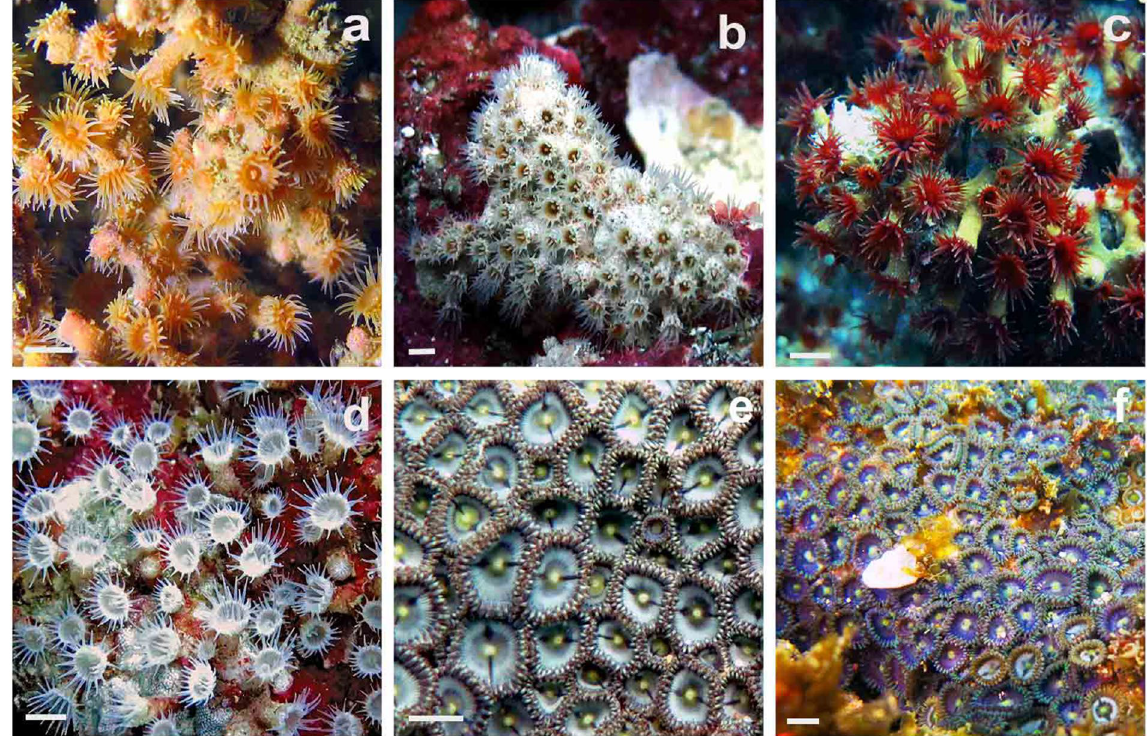
Figure 1. In situ images of the six zoantharians species discussed. ( a ) Parazoanthus darwini (Z1); ( b ) Antipathozoanthus hickmani (Z2); ( c ) Terrazoanthus patagonichus (Z3); ( d ) Terrazoanthus sp. (Z4); ( e ) Zoanthus cf. pulchellus (Z5); ( f ) Zoanthus cf. sociatus (Z6). The scale bar represents 1 cm. (Pictures from K.B.